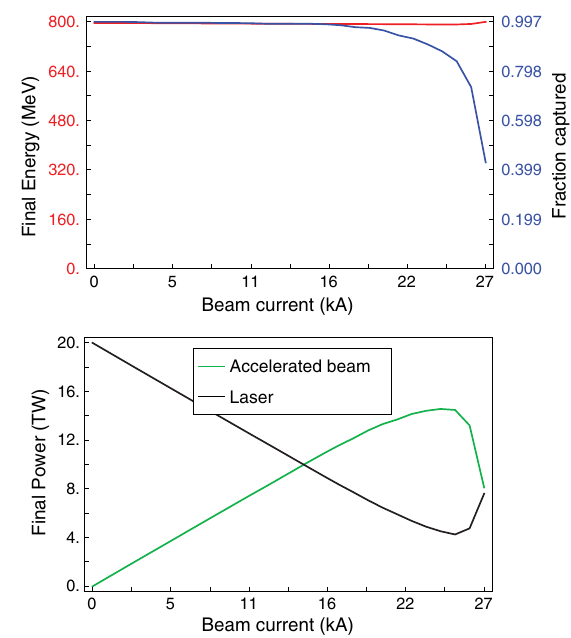
FIG. 12. Output IFEL parameters as functions of input beam current for a compensated tapered undulator designed for 20